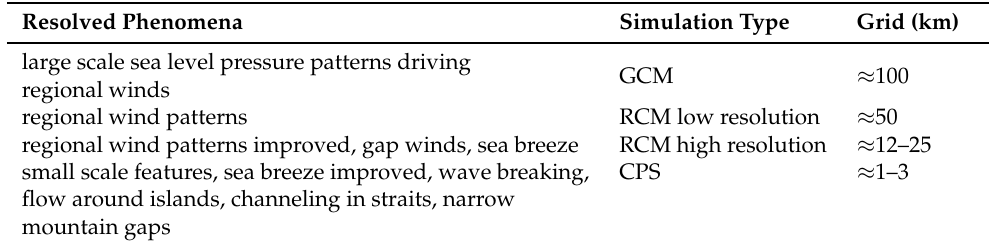
Table 3. Resolved phenomena and grid spacing for each simulation type: global circulation models (GCM), regional climate models (RCM), and convection permitting simulations (CPS). Resolved Phenomena Simulation Type Grid (km) large scale sea level pressure patterns driving GCM ≈ 100 regional winds regional wind patterns RCM low resolution ≈ 50 regional wind patterns improved, gap winds, sea breeze RCM high resolution ≈ 12–25 small scale features, sea breeze improved, wave breaking, CPS ≈ 1–3 flow around islands, channeling in straits, narrow mountain